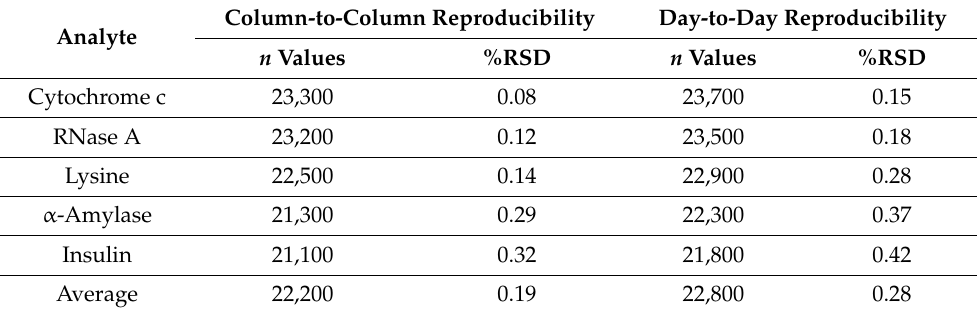
Figure 5. Separation of proteins on C18-bound SM column (1.8 mm × 100 mm); flow rate (100 µL/min), mobile phase 70/30 ACN/water with 0.1% TFA. Analytes: 1 Cytochrome c; 2 RNase A; 3 Lysine; 4 α -Amylase; and 5 Insulin. Table 4. Batch and time reproducibility of C18-bound SM column (1.8 mm × 100 mm) for protein separation.